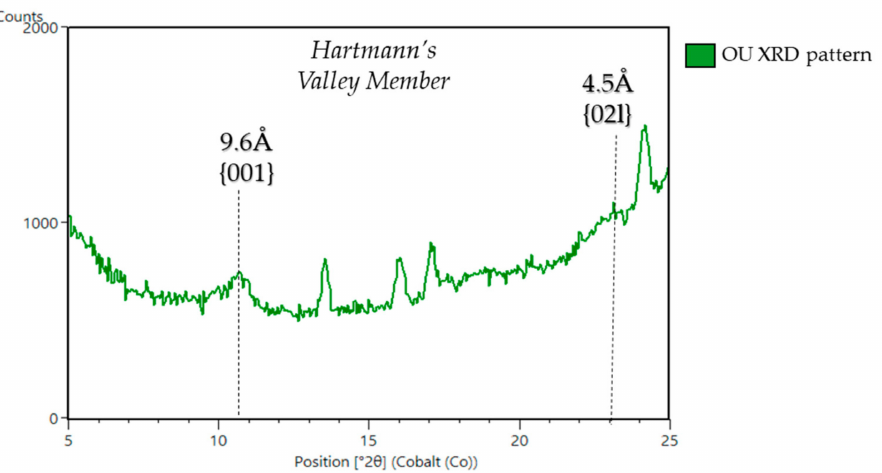
Figure 13. CheMin XRD pattern from 5 ◦ to 25 ◦ 2 θ of the Hartmann’s Valley member drilled sample, OU. The d(001) and d(02l) peak positions are identified at 9.6 Å and 4.5 Å,